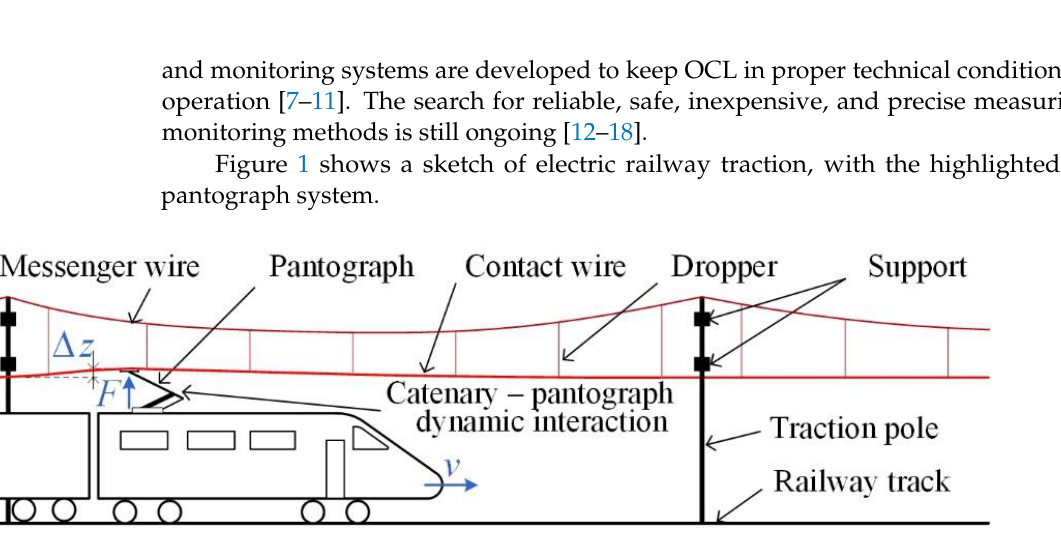
Figure 1. The OCL –pantograph system with marked: pantograph’s action with force F ( t ), contact Figure 1. The OCL—pantograph system with marked: pantograph’s action with force F ( t ), contact wire uplift  z ( t ), and vehicle speed v ( t ). wire uplift ∆ z ( t ), and vehicle speed v ( t